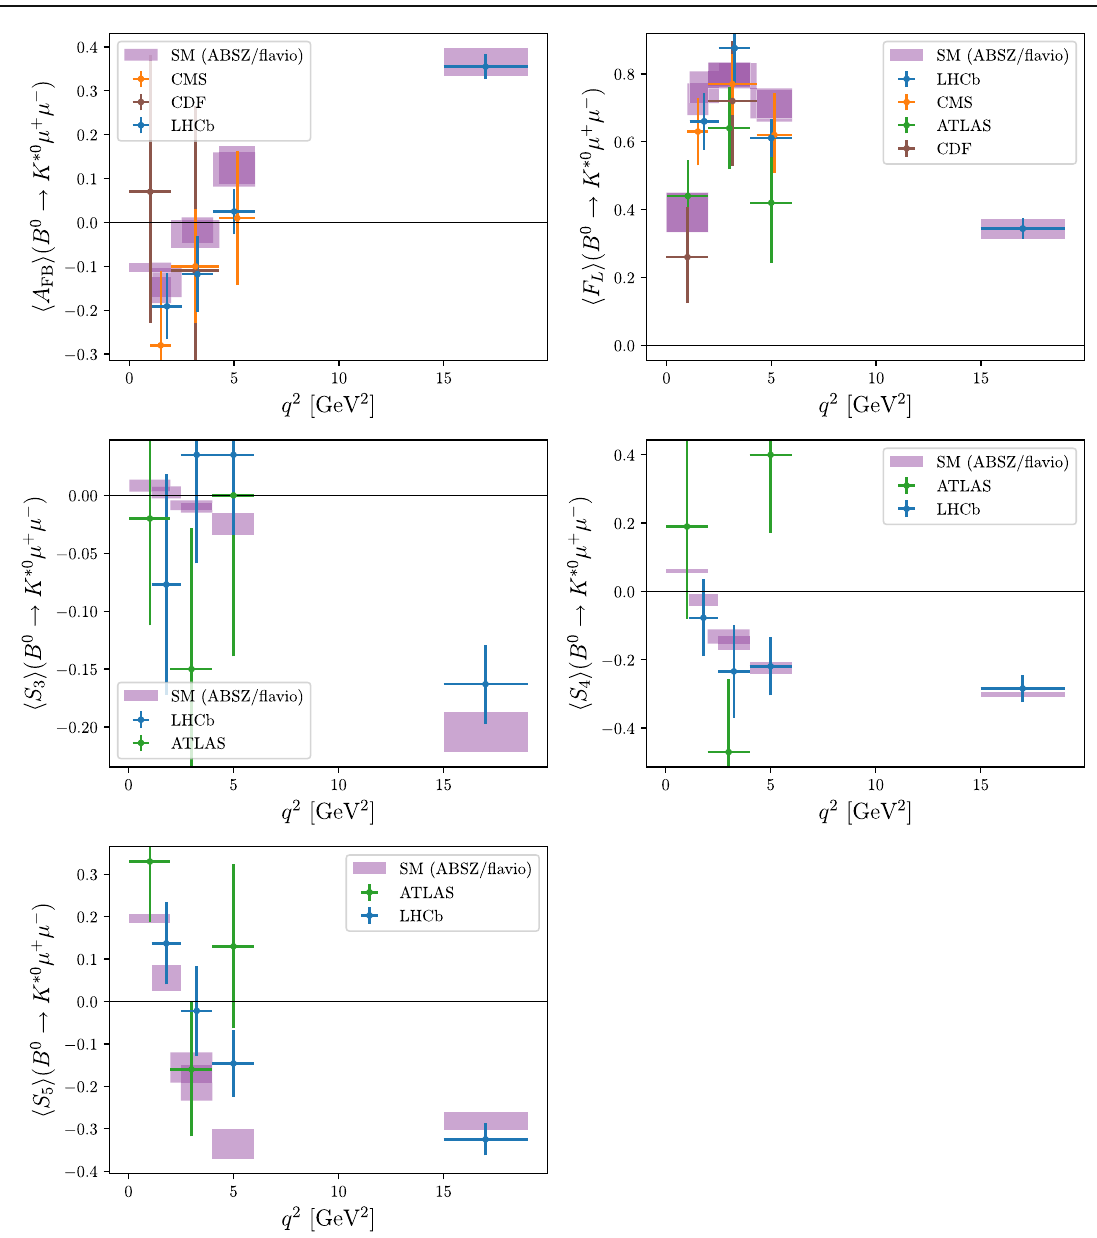
Fig. 6 Experimental measurements vs. SM predictions for the B → K ∗ μ + μ − angular observables. “ABSZ” refers to